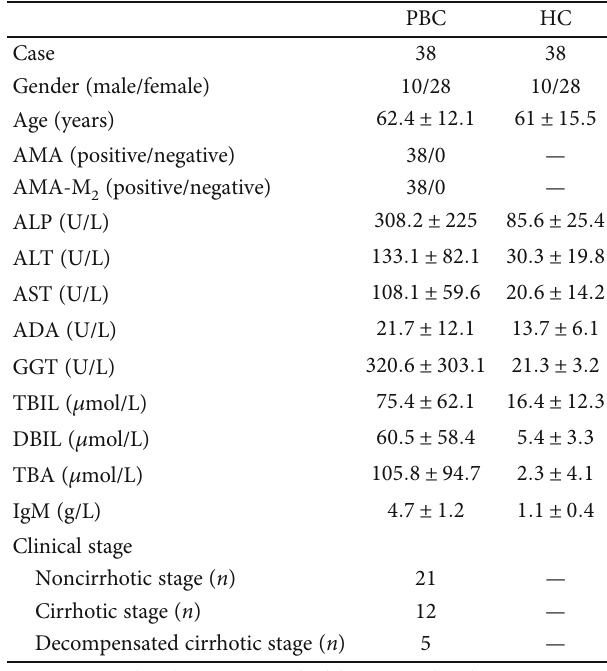
Table 1: Clinical features and biochemical parameters of the PBC patients enrolled in this